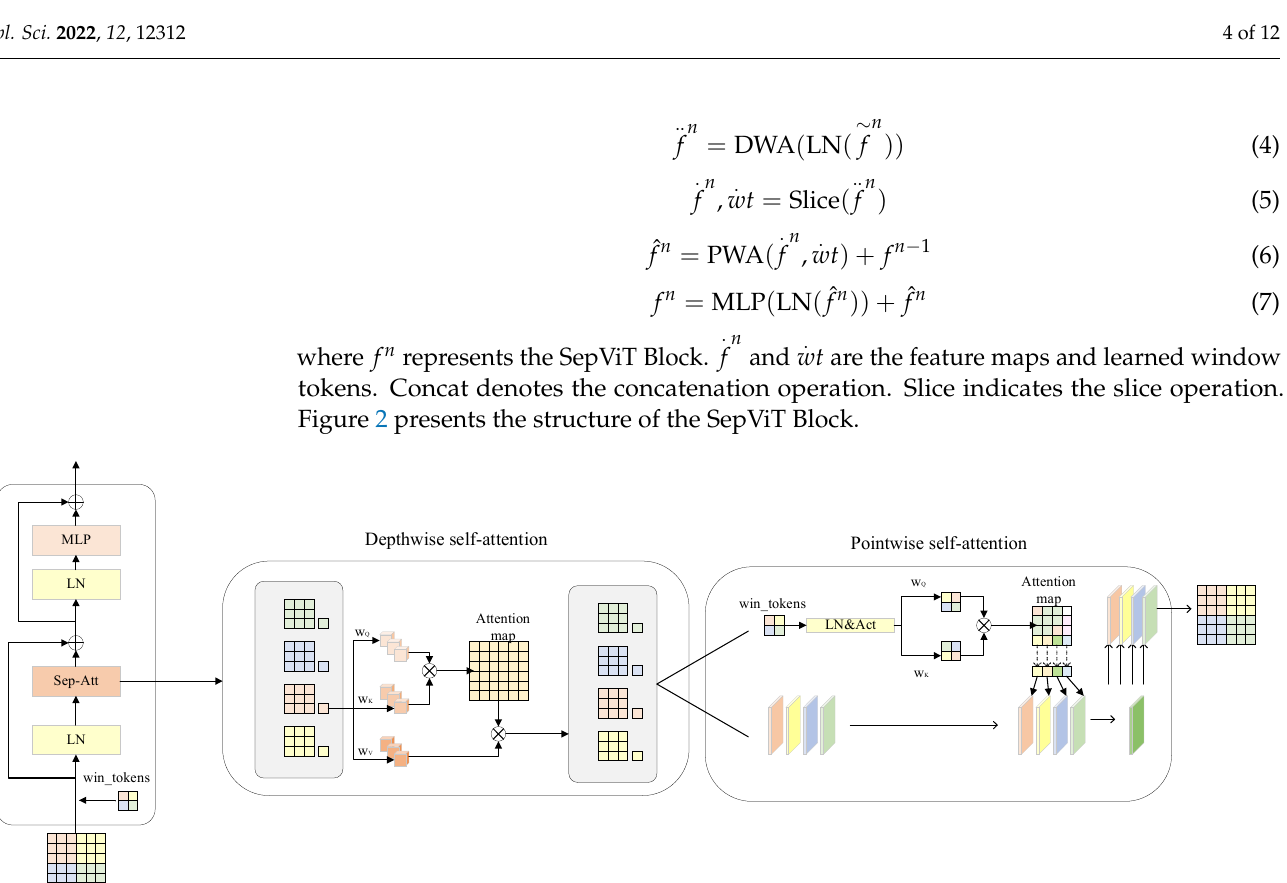
Figure 2. The overall structure of the SepViT Block. MLP represents Multi-Layer Perceptron. Sep-Att represents Separable attention